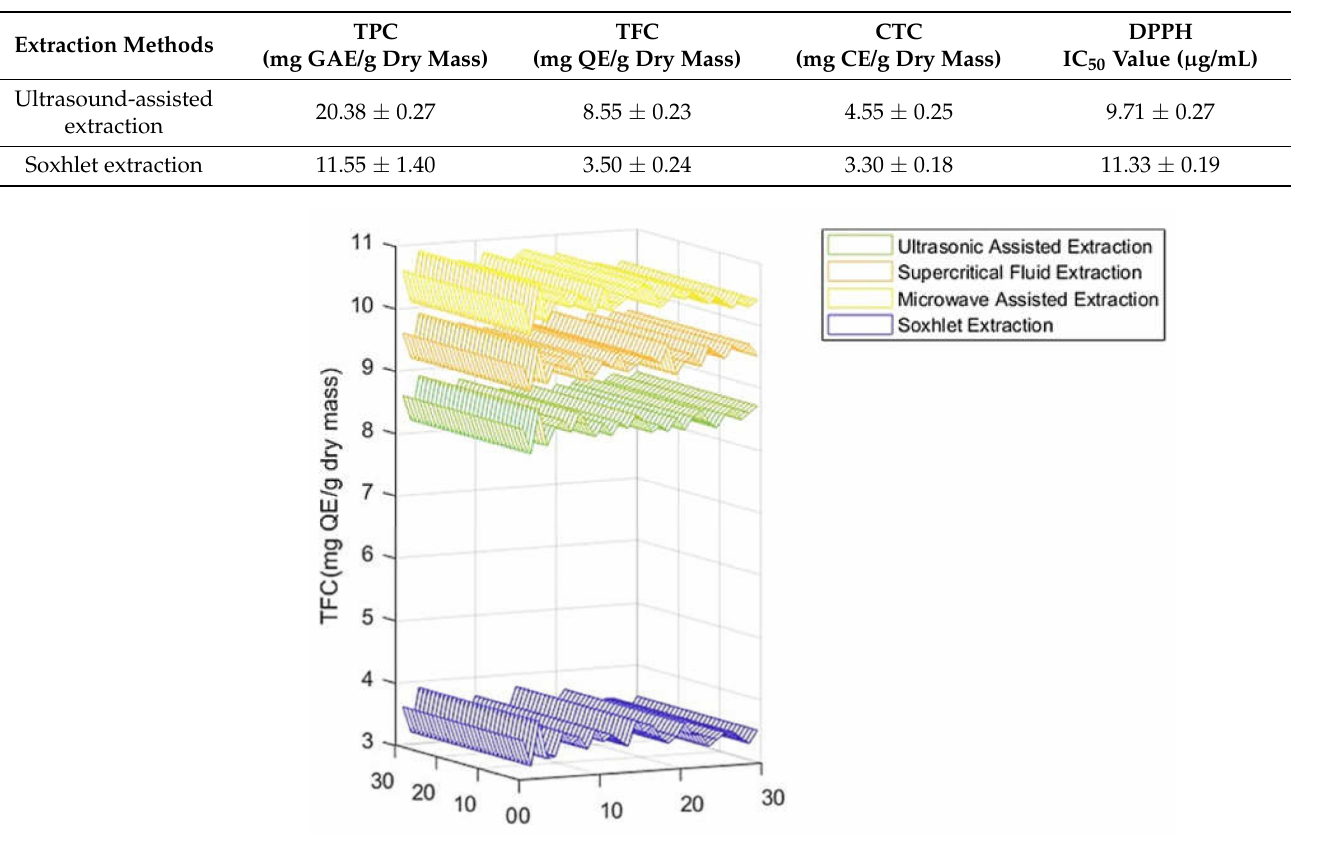
Figure 2. TFC of carob pod extracts using different extraction methods.